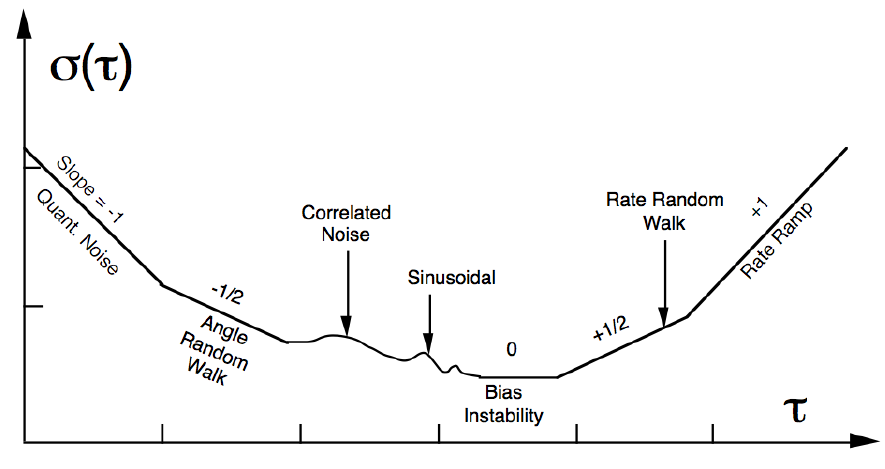
Figure 2. Allan variance plot from the IEEE Std 952-1997 for typical data analysis [8]. The cluster time of length τ could take different units in time (e.g., microseconds, seconds, minutes or hours) as well as σ ( τ ) , i.e. , angular velocity (e.g., rad/s or ◦ /h ) for gyros